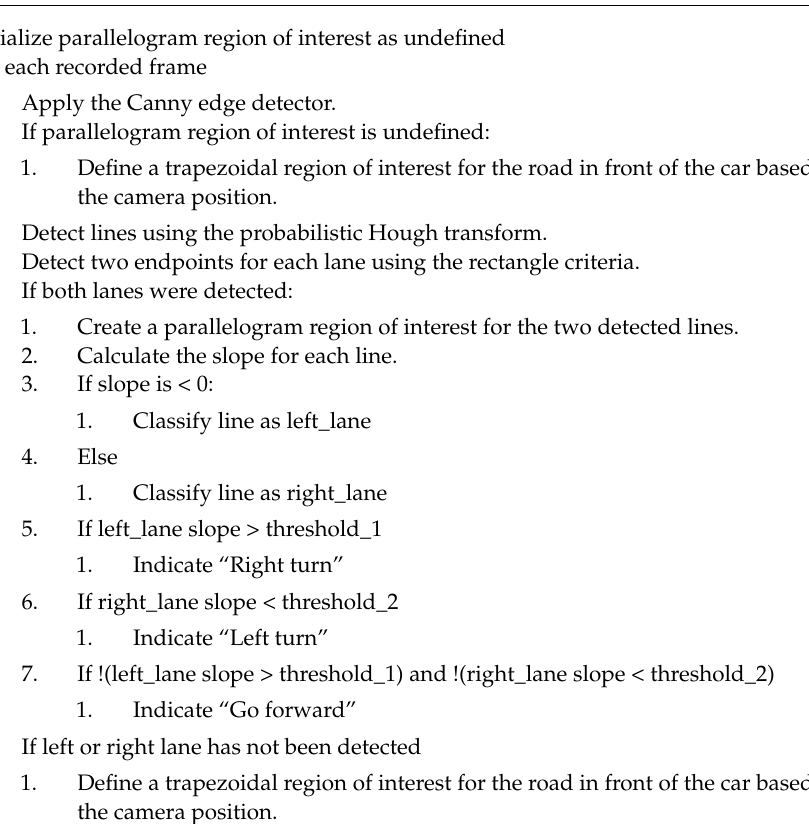
Algorithm 1. The proposed lane detection